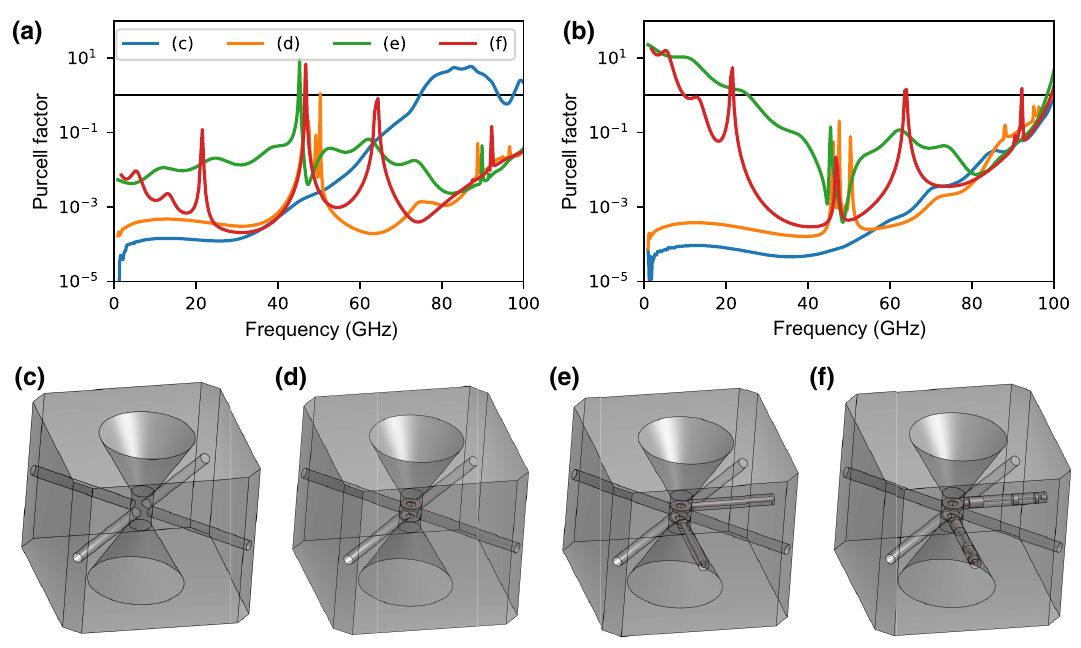
FIG. 9. (a) σ ± -polarized Purcell factor and (b) ˆ z -polarized Purcell factor for the microwave structure built up one component at a time. The legend labels refer to the illustrations in parts (c)–(f). (c) Waveguide only. (d) Waveguide with annular electrodes included. (e) Waveguides, annular electrodes, and coaxial feedthroughs to apply a bias voltage, terminated with 50 (cid:15) (not shown). (f) As (e), but with stepped-impedance filters added to the